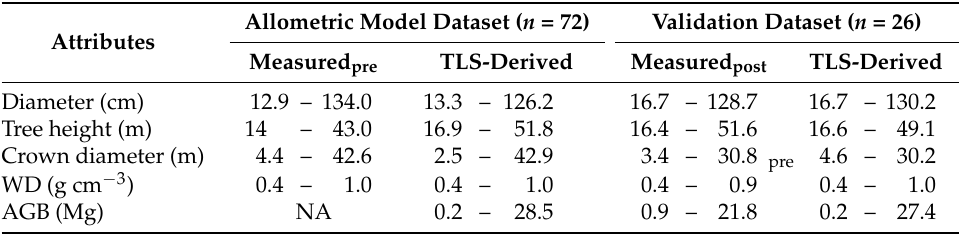
Table 2. Pre- and post-harvested field measured attributes, and terrestrial laser scanning (TLS)-derived attributes range for: diameter ( D ), height ( H ), crown diameter ( CD ), wood density ( WD ; see note below) and aboveground biomass (AGB). Allometric Model Dataset ( n =